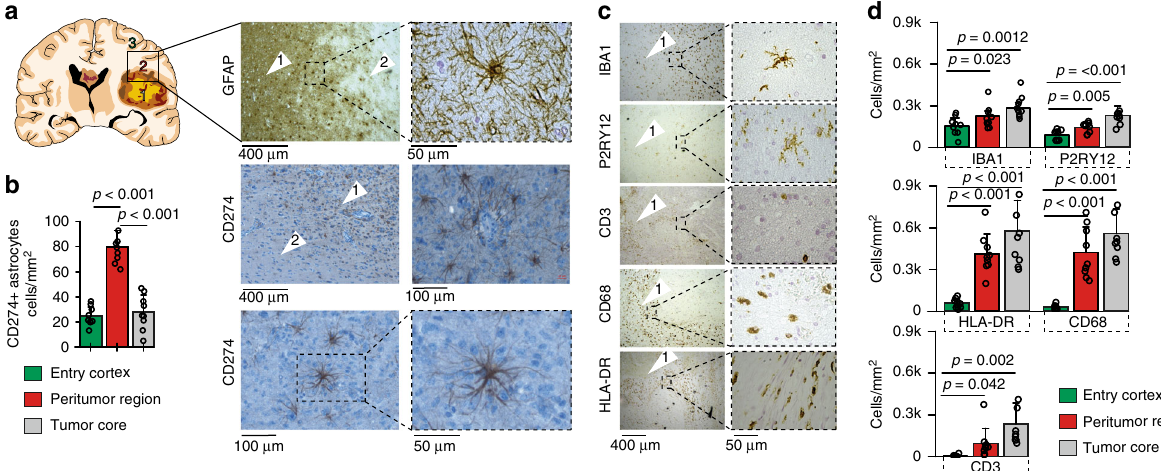
Fig. 2 CD274 + -astrocytes in glioblastoma specimens. a Immunohistochemistry of GFAP and CD274 of the tumor margin, arrows indicate the regions illustrated in the left panel. b Each dot represents the average number (3 fi elds per sample) of astrocytes per cm 2 in entry cortex ( n = 9), peritumoral region ( n = 9) and the tumor core ( n = 10). Exact values, as well as statistical analysis are given in the source fi le. c Immunohistochemistry of the myeloid landscape of the tumor margin, microglia were marked by IBA1 and P2RY12, T-cells by CD3, tumor-associated macrophages/activated microglia by CD68 and HLA-DR. d Each dot represents the average number of cells per cm 2 in all different regions (3 fi elds per sample). Exact values, as well as statistical analysis are given in the source fi le. Arrow 1: Tumor Core; Arrow 2: Peritumoral Tissue and In fi ltrating Region; Arrow 3: Non-In fi ltrating Region. P -values are determined by one-way ANOVA ( d ) adjusted by Benjamini-Hochberger for multiple testing. Data is given as mean ± standard